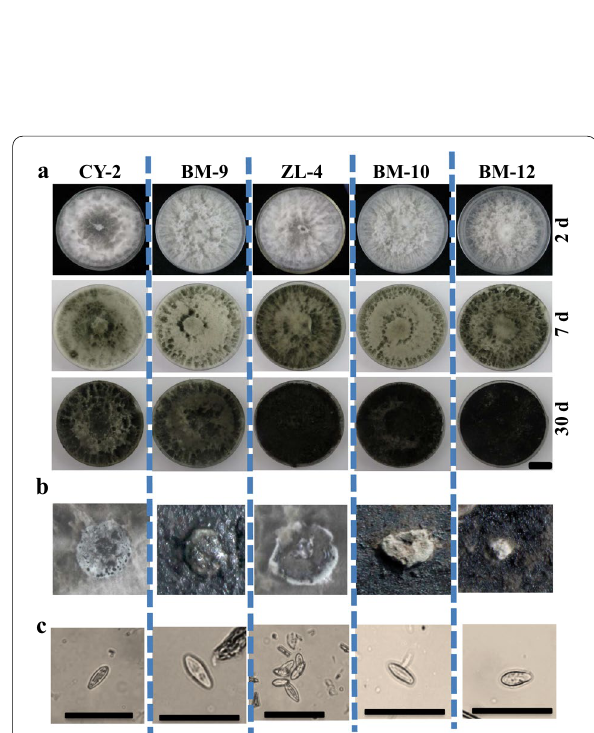
Fig. 2 Morphological and cultural features of N. parvum isolates. a Cultural features. Five isolates were cultured on PDA medium at 25 °C for 2, 7 and 30 days. Bar 10 mm. b Pycnidia of the isolates. The = pycnidia were induced at room temperature for 30 days under 16/8 light/dark. c Conidial features of the isolates. Conidia were obtained from broken pycnidium. Images were obtained using a Zeiss microscope, with the sizes of the conidia measured using the image capturing